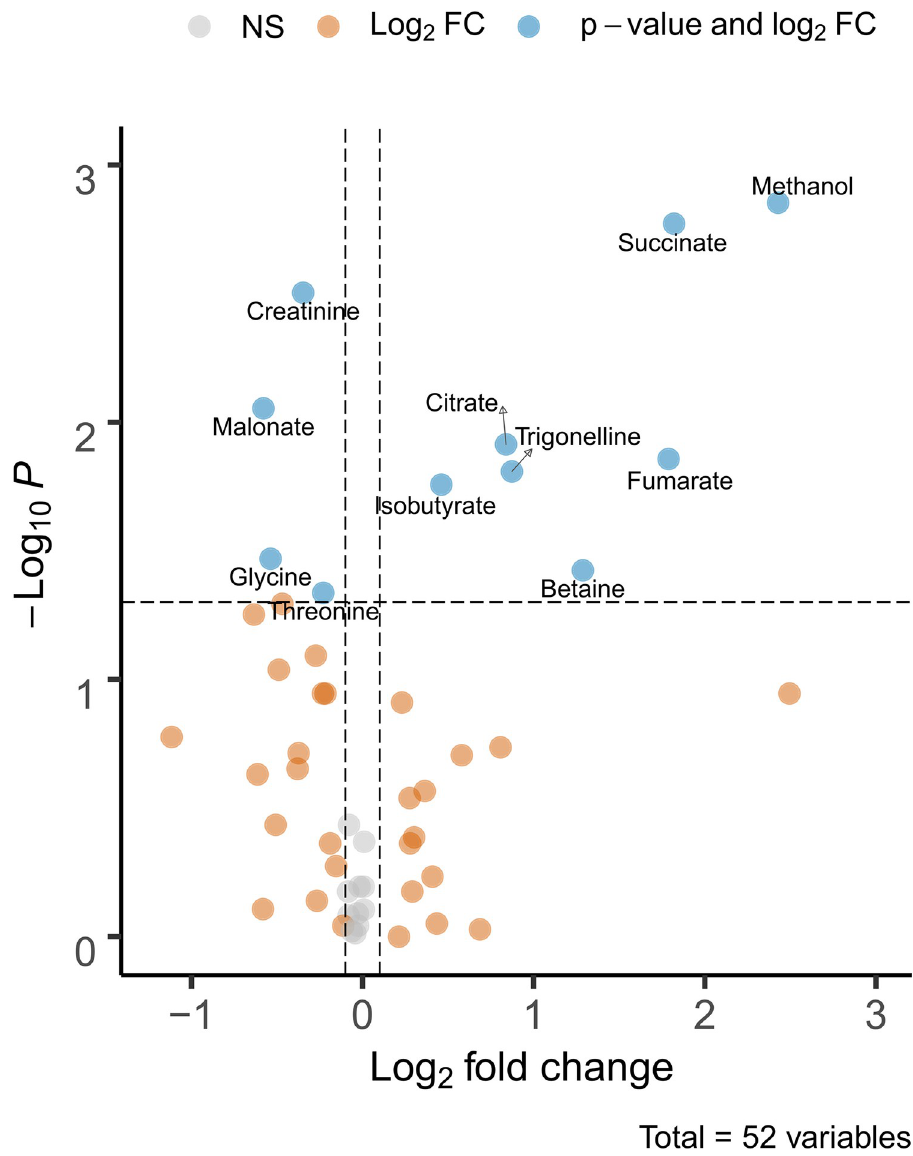
baseline. NS: No change, FC: Fold